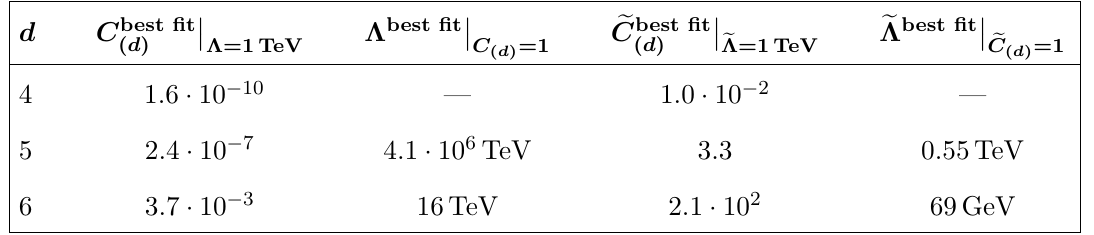
Table 1 . Values for Wilson coe(cid:14)cients and NP at the best-(cid:12)t point. For each operator the best-(cid:12)t mass of the new resonance is approximately 208 MeV. The normalization of the Wilson coe(cid:14)cients e C ( d ) is de(cid:12)ned in eqs.